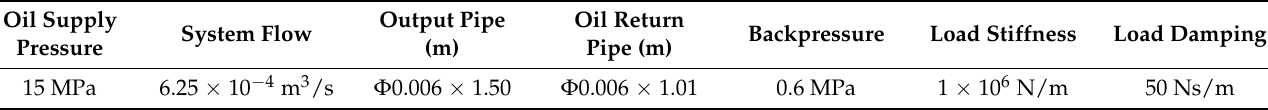
Table 2. The parameters of experimental platform.